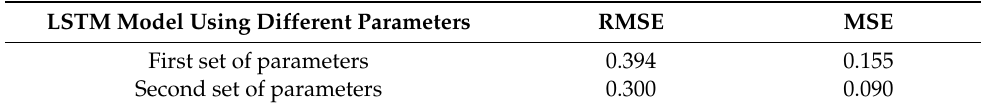
Table 4. RMSE and MSE values of the model when using different parameters.